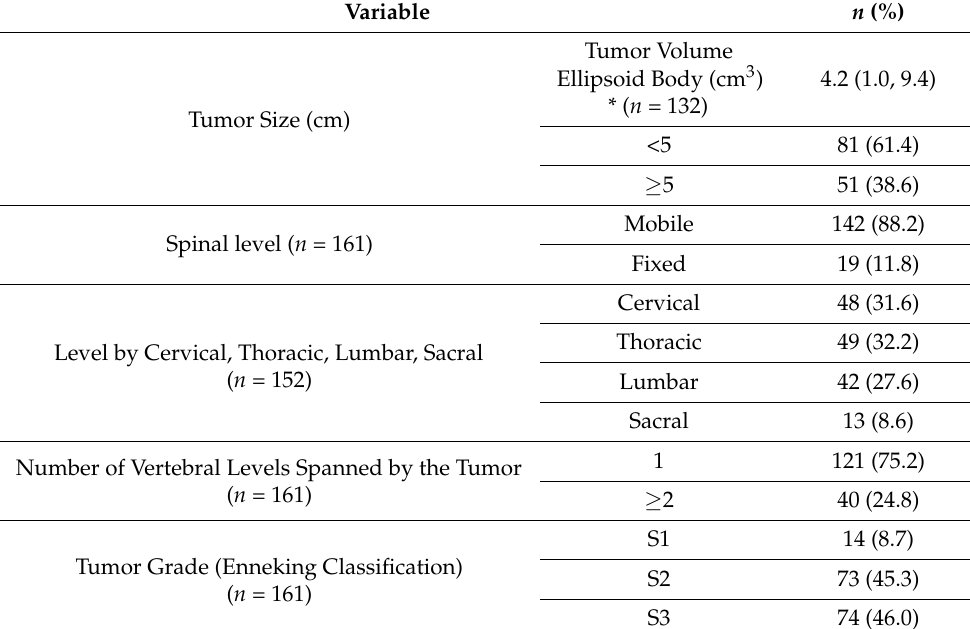
Table 2. Summary of tumor characteristics.